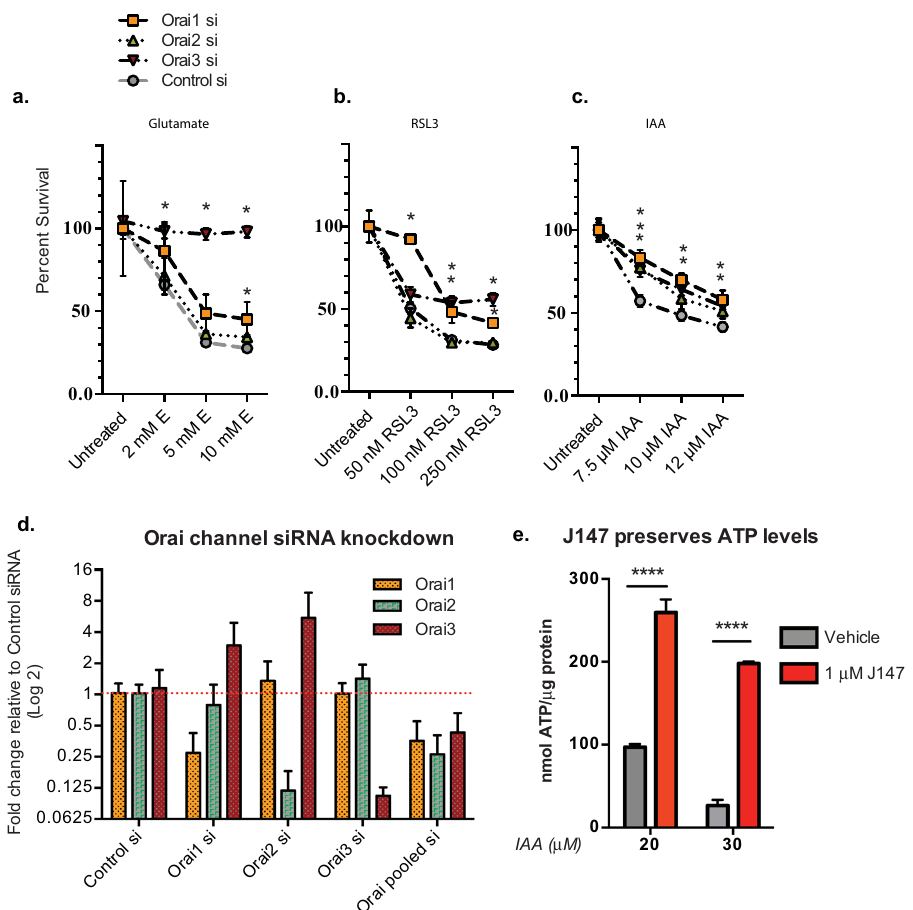
Fig. 6 Orai siRNA-mediated knockdowns improve cell survival. HT22 cells were transfected with siRNA to Orai 1, 2, or 3 and assessed for cell viability after 24 h treatment with a 10 mM glutamate, b 250 nM RSL3, or c 12 μ M IAA ( n = 3 exp., multiple t -test (Holm – Sidak method); df = 4; *p < 0.05). d qPCR validation of Orai channel knockdown. e 1 μ M J147 preserves ATP levels during 20 and 30 μ M IAA treatment. p < 0.05 ( n = 3 exp., unpaired t